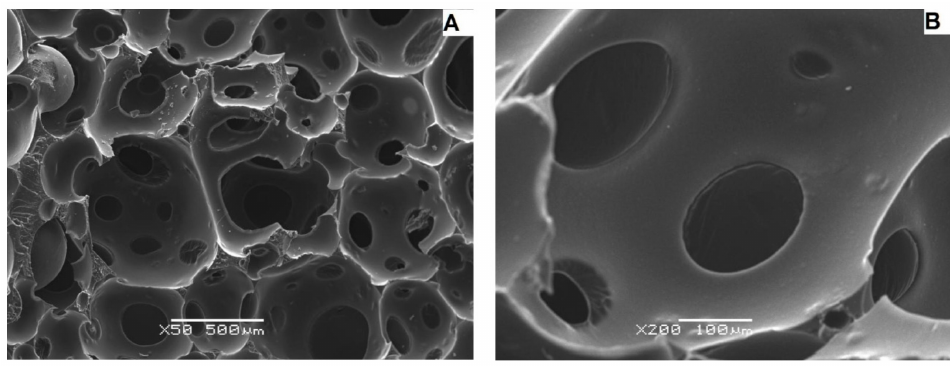
Figure 10. Micrographs of the carbon M3 sample taken with the use of SEM at various approximations: